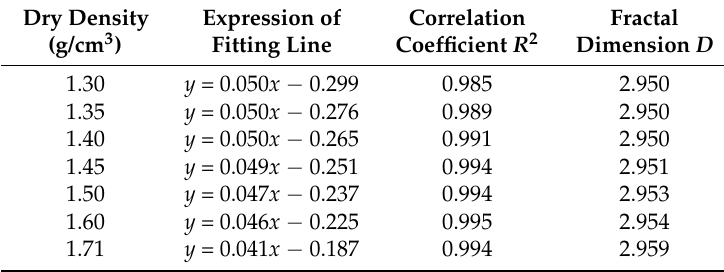
Table 2. Fitting results of fractal dimension corresponding to Figure 6b.